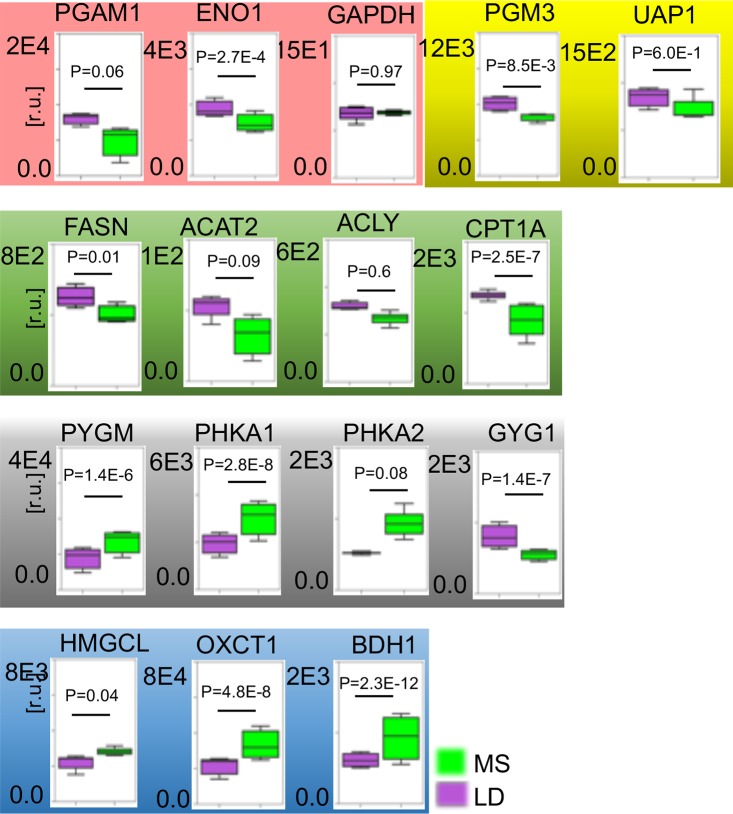
Myocardial mRNA response to MetS.RNA-seq is applied to evaluate relative changes in mRNA levels of enzymes in myocardial MetS and LD tissue. Plots show mRNA levels in MetS (green barrels) versus LD (purple) of four individual MetS swine and four LD swine; PGAM1(p = 6.2x10-2), ENO1 (p = 2.7x10-4), GAPDH (p = 0.97); PGM3 (p = 8.5x10-3), UAP1 (p = 6x10-1), FASN (p = 0.01); ACAT2 (p = 0.09), ACLY (p = 0.6), CPT1A (p = 2.5x10-7), HMGCL (p = 0.04), OXCT1 (p = 4.8x10-8), BDH1 (2.4x10-12), PYGM (p = 1.4x10-6), PHKA1 (p = 2.8x10-8), PHKA2 (p = 0.08) and GYG1 (p = 1.4x10-7). Data are presented as means ±SD (normalized counts LD = 4, MetS = 4; p<0.05 were considered statistically significant; padj reported in supporting S2 Table). The mRNA identity is shown above the plots. mRNAs for enzymes with functions in the glycolysis pathway are highlighted in pink; hexosamine biosynthetic pathway in yellow; green—fatty acids metabolism; glycogen breakdown, metabolism, and synthesis in gray; mitochondrial ketone body formation, transport, and utilization in blue.